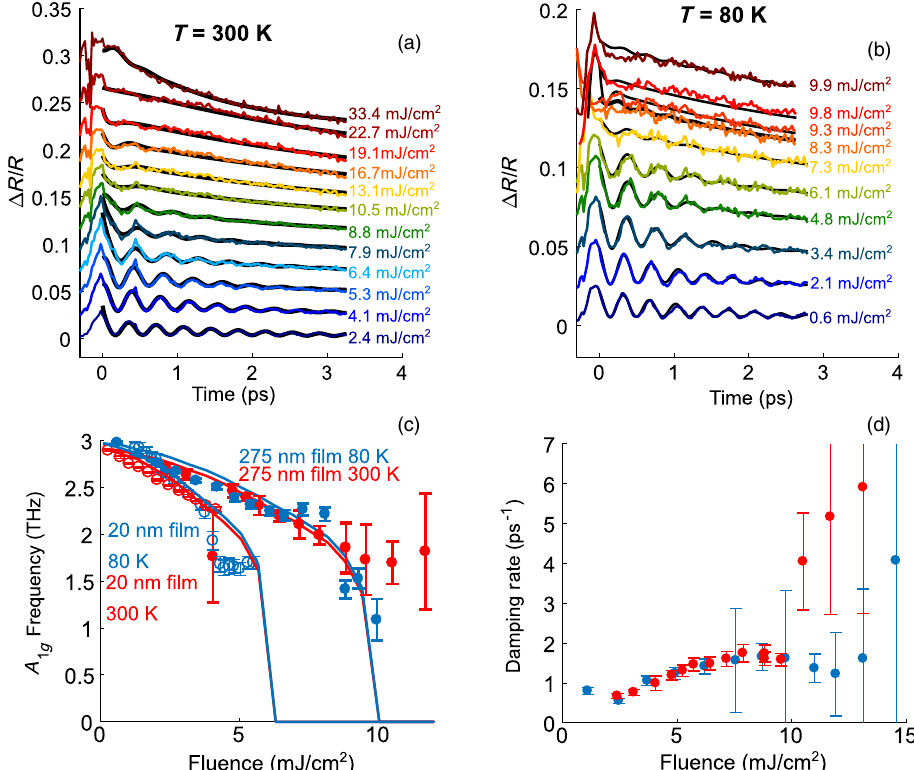
FIG. 2. (a) Single-shot pump-probe traces for 275-nm Bi films with an initial temperature of 300 K. (b) Single-shot pump-probe traces for 275-nm Bi films with an initial temperature of 80 K. In (a) and (b), the colored lines are experimental data, and the black curves are fits of the experimental data to Eqs. (1) and (2), as described in the text. (c) The coherent phonon frequency at 300 and 80 K as a function of the fluence for two separate films: one 20 nm thick and one 275 nm thick. Lines are simulation curves calculated using the photoexcited carrier density from an extended two-temperature model [21] and the carrier density-dependent anharmonic lattice potential [3]. At high fluences, the fitting used to calculate a damping rate breaks down when the coherent phonons vanish (above 10 . 5 mJ = cm 2 in the 275-nm film at 300 K and above 9 mJ = cm 2 at 80 K). The probe wavelength for all traces in this figure is 800 nm, and traces are offset for clarity. (d) The damping rate of the coherent oscillations, which increases with photoexcitation